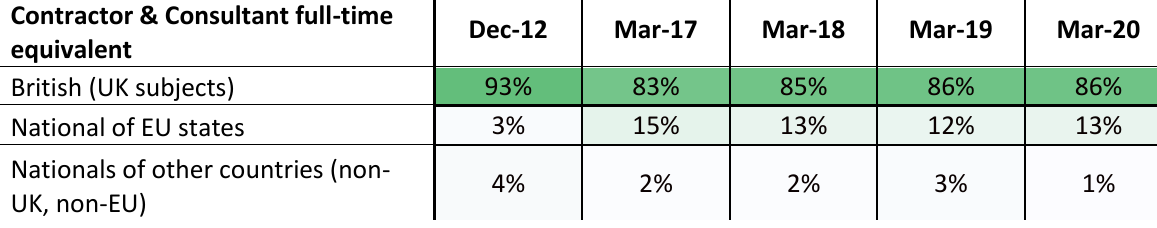
Table 4: Nationalities of staff (UK respondents) in 2012 and then 2017-20. 2012 was a Profiling the Profession exercise and represents the whole sector, not just those in commercial